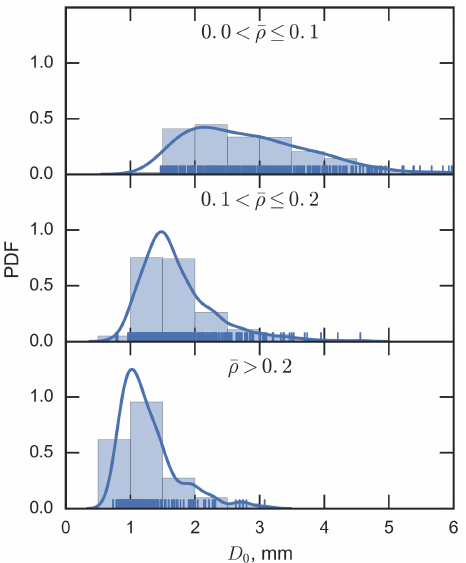
Figure 10. Normalized frequency (bars) and kernel density (line) of median volume diameter D 0 in three ensemble mean density ranges, [ ρ ] = gcm − 3